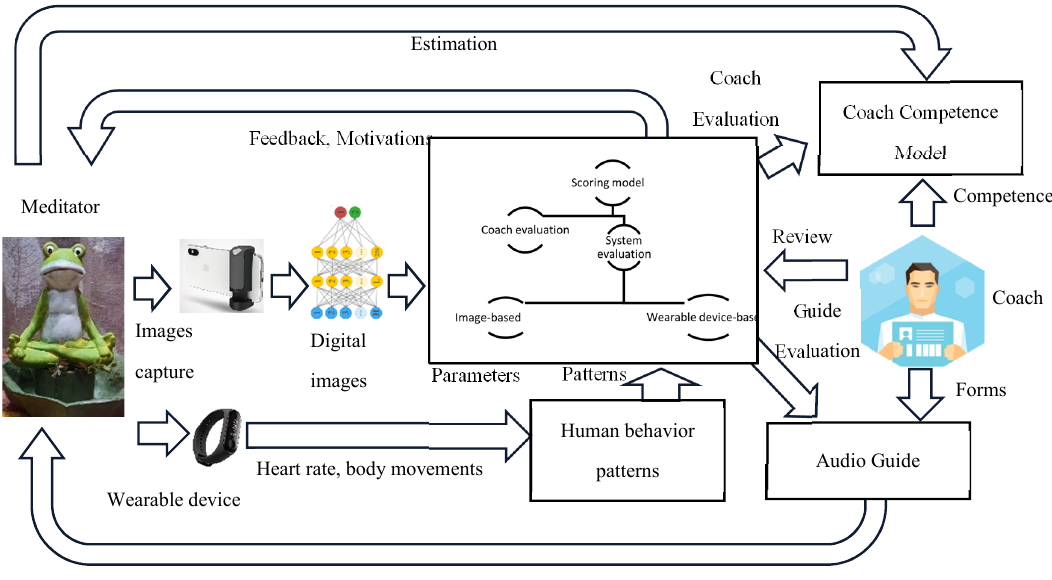
Figure 4. Reference model of the psychophysiological activity detection system.